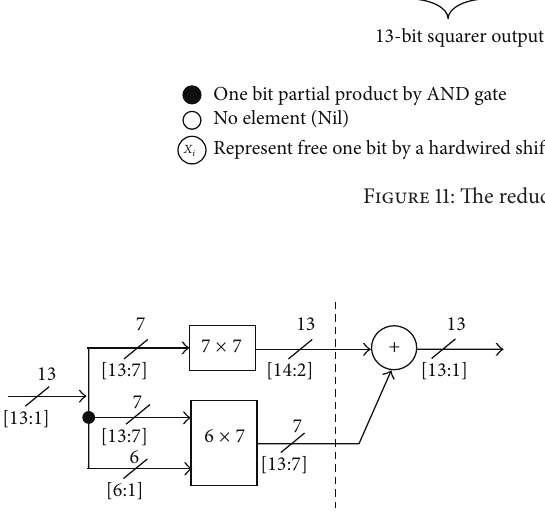
ALTERA Stratix IV FPGA (EP4SGX230KF40C2 device)